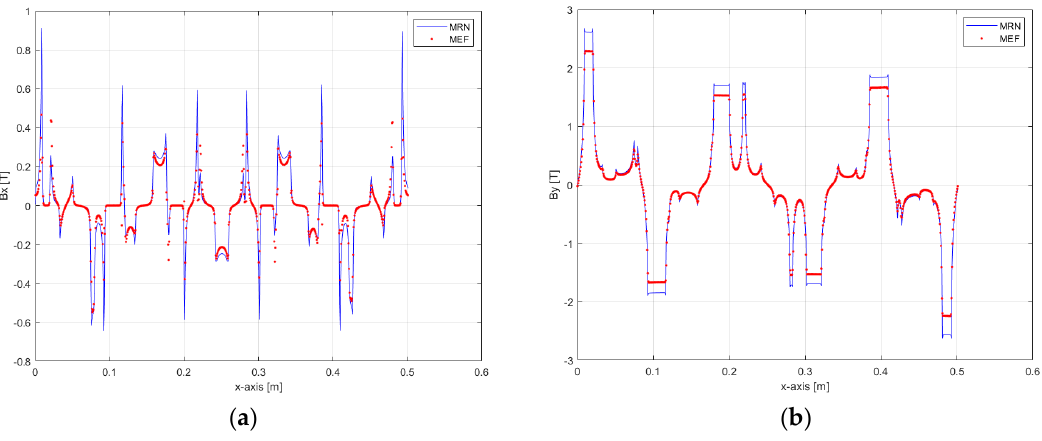
Figure 15. Comparison between the results from the 2D RN and 2D FEM: ( a ) magnetic induction x component in the airgap (tangential component); ( b ) magnetic induction y component in the airgap (normal component).